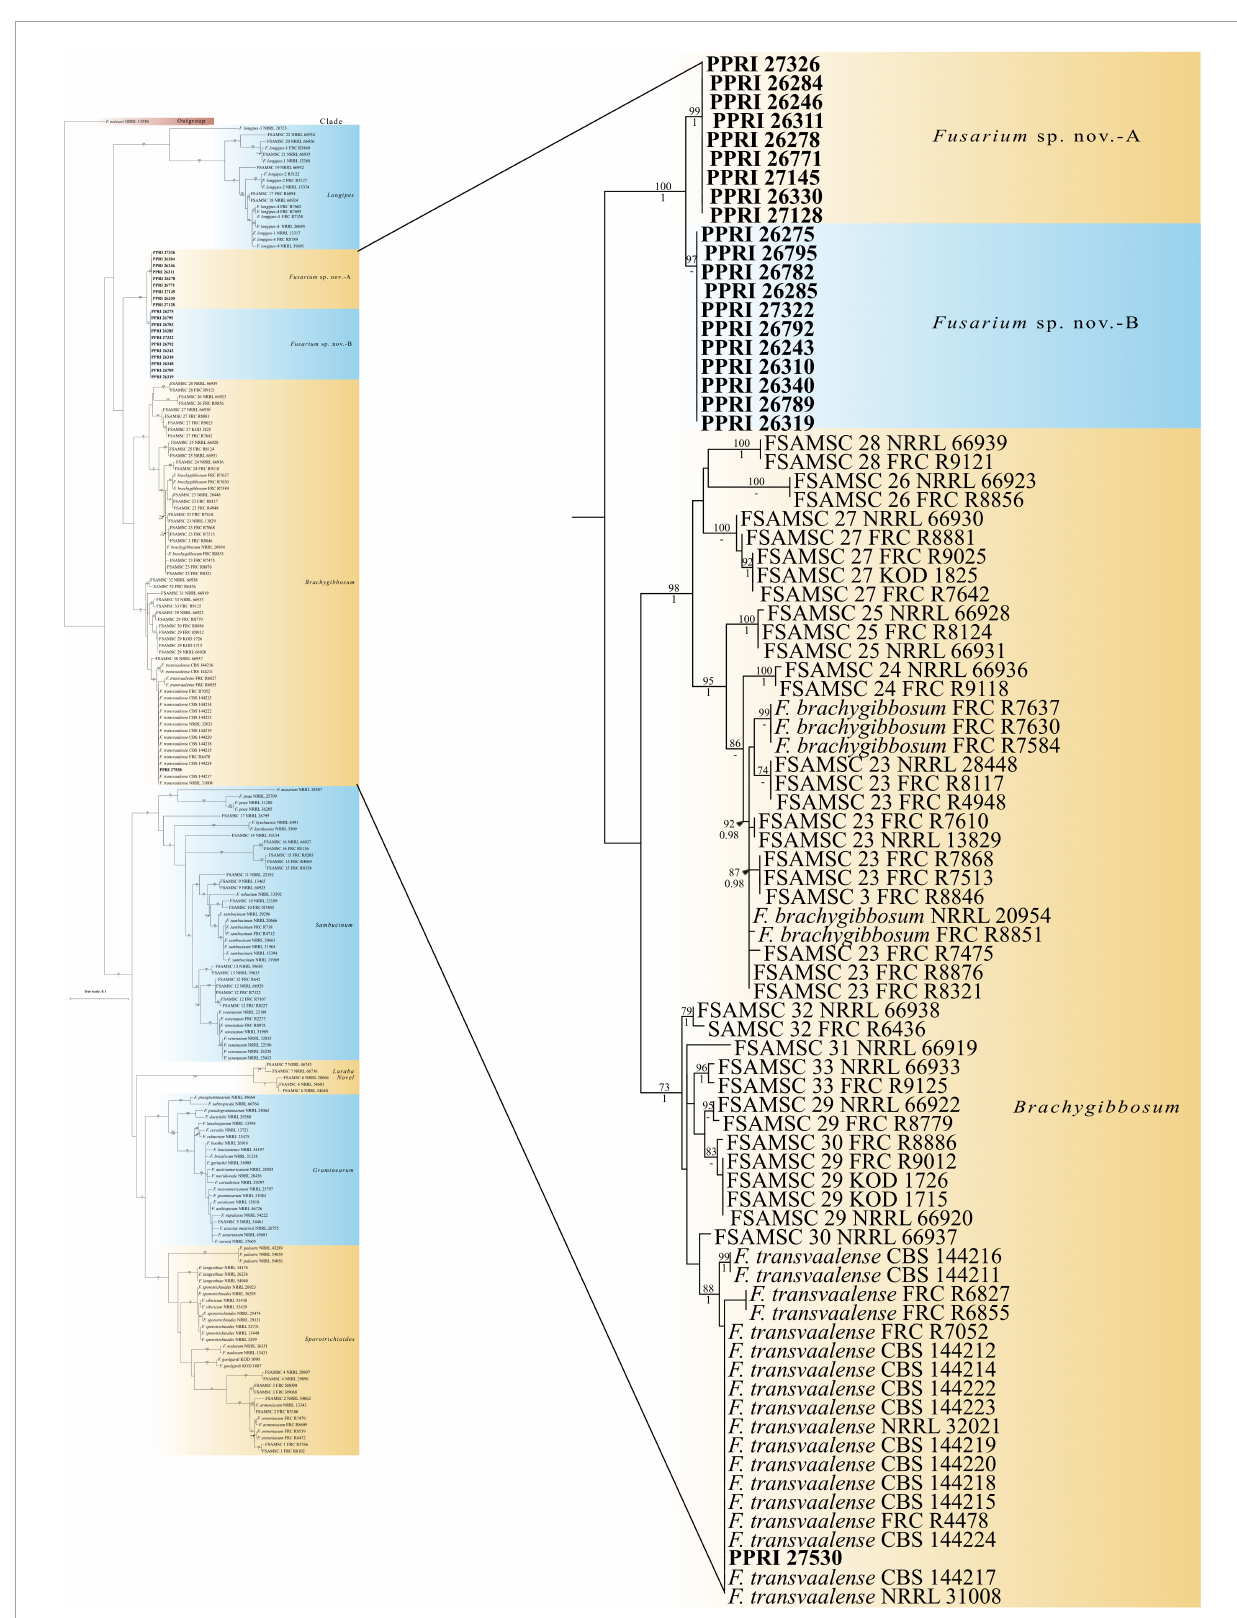
FIGURE6 Phylogenetic tree of the FSAMSC dataset inferred from the tef-1 α gene region for 204 taxa. Isolates from the GGHNP are indicated by PPRI number and are marked in bold. Branch support values are indicated as ML-BS/PP values ( > 0.98/ > 70%) above the branches at the corresponding nodes.